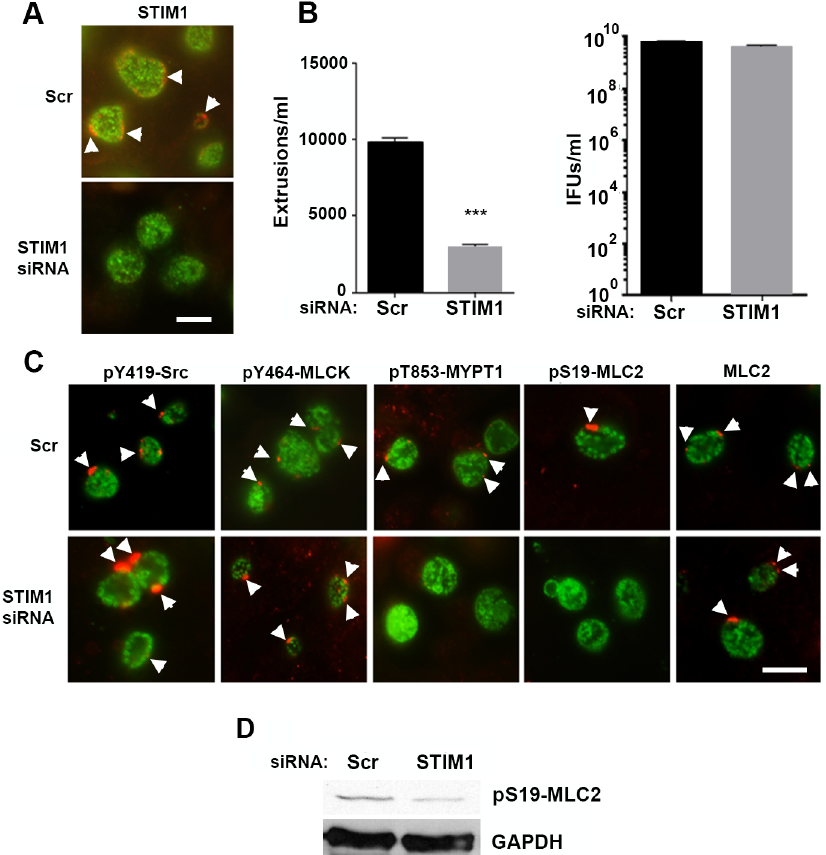
Fig 6. Effect of STIM1 depletion on extrusion formation and recruitment of pT853-MYPT1 and pS19-MLC2 to the chlamydial inclusion. STIM1 was depleted from HeLa cells using siRNA and infected with C . trachomatis L2. (A) STIM1 depletion was confirmed by immunofluorescence on C . trachomatis -infected cells using an anti-STIM1 antibody (red) (arrowheads). (B) Extrusions were significantly reduced (n = 3; error bars indicate SEM, the difference was significant at P < 0.0001; (cid:3)(cid:3)(cid:3)(cid:3) ) by an unpaired Students T-test at 48 hrs post-infection with no significant reduction in progeny formation. (C). At 24 hrs post infection, HeLa cells transfected with siRNA against STIM1 or a scrambled control siRNA (Scr) were fixed and stained with anti-pY419-SFK (red), anti-pY464-MLCK (red), anti-pT853-MYPT1 (red), anti-pS19-MLC2 (red), anti-MLC2 (red) (all red labeling of microdomains is indicated by arrowheads), and anti- MOMP (green). Bar = 10 μ m. (D) Immunoblot showing reduction in STIM1 in siRNA treated cells.